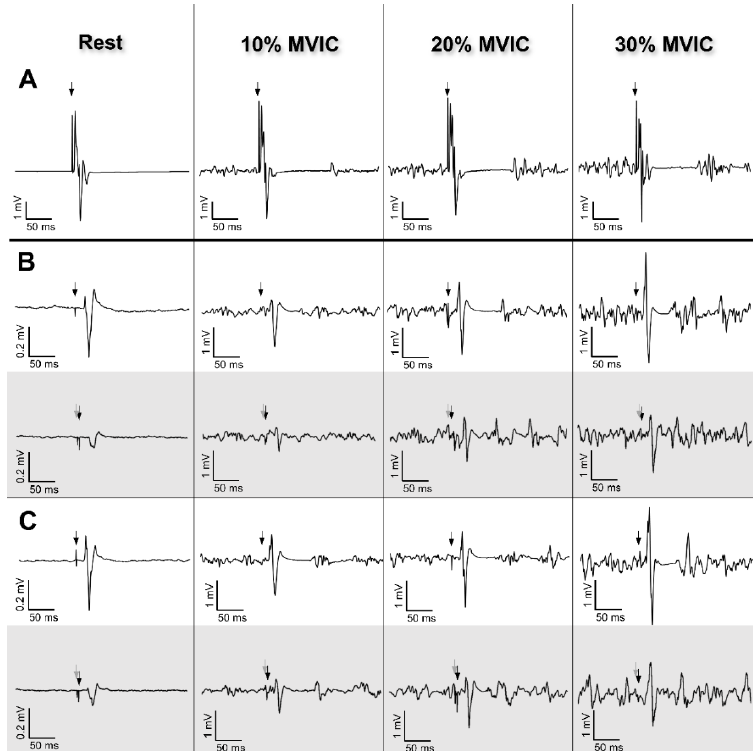
Figure 2. Typical raw data recordings of the right FCR muscle depicted at rest, 10%, 20% and 30% of maximal voluntary isometric contraction (MVIC) for a representative participant. Black and grey vertical arrows indicate time of stimulation for test and conditioning stimuli, respectively. ( A ) Maximal M-wave (Mmax) induced by electrical stimulation. ( B ) Unconditioned (white) and conditioned (grey) motor-evoked potentials (MEPs) with the test stimulus induced at 120% of the motor threshold. ( C ) Unconditioned (white) and conditioned (grey) MEP with the test stimulus induced at 130% of the motor threshold. Note that the y -axis scale for MEPs amplitude differs between resting and active conditions (i.e., 0.2 mV vs. 1 mV) for a better graphical